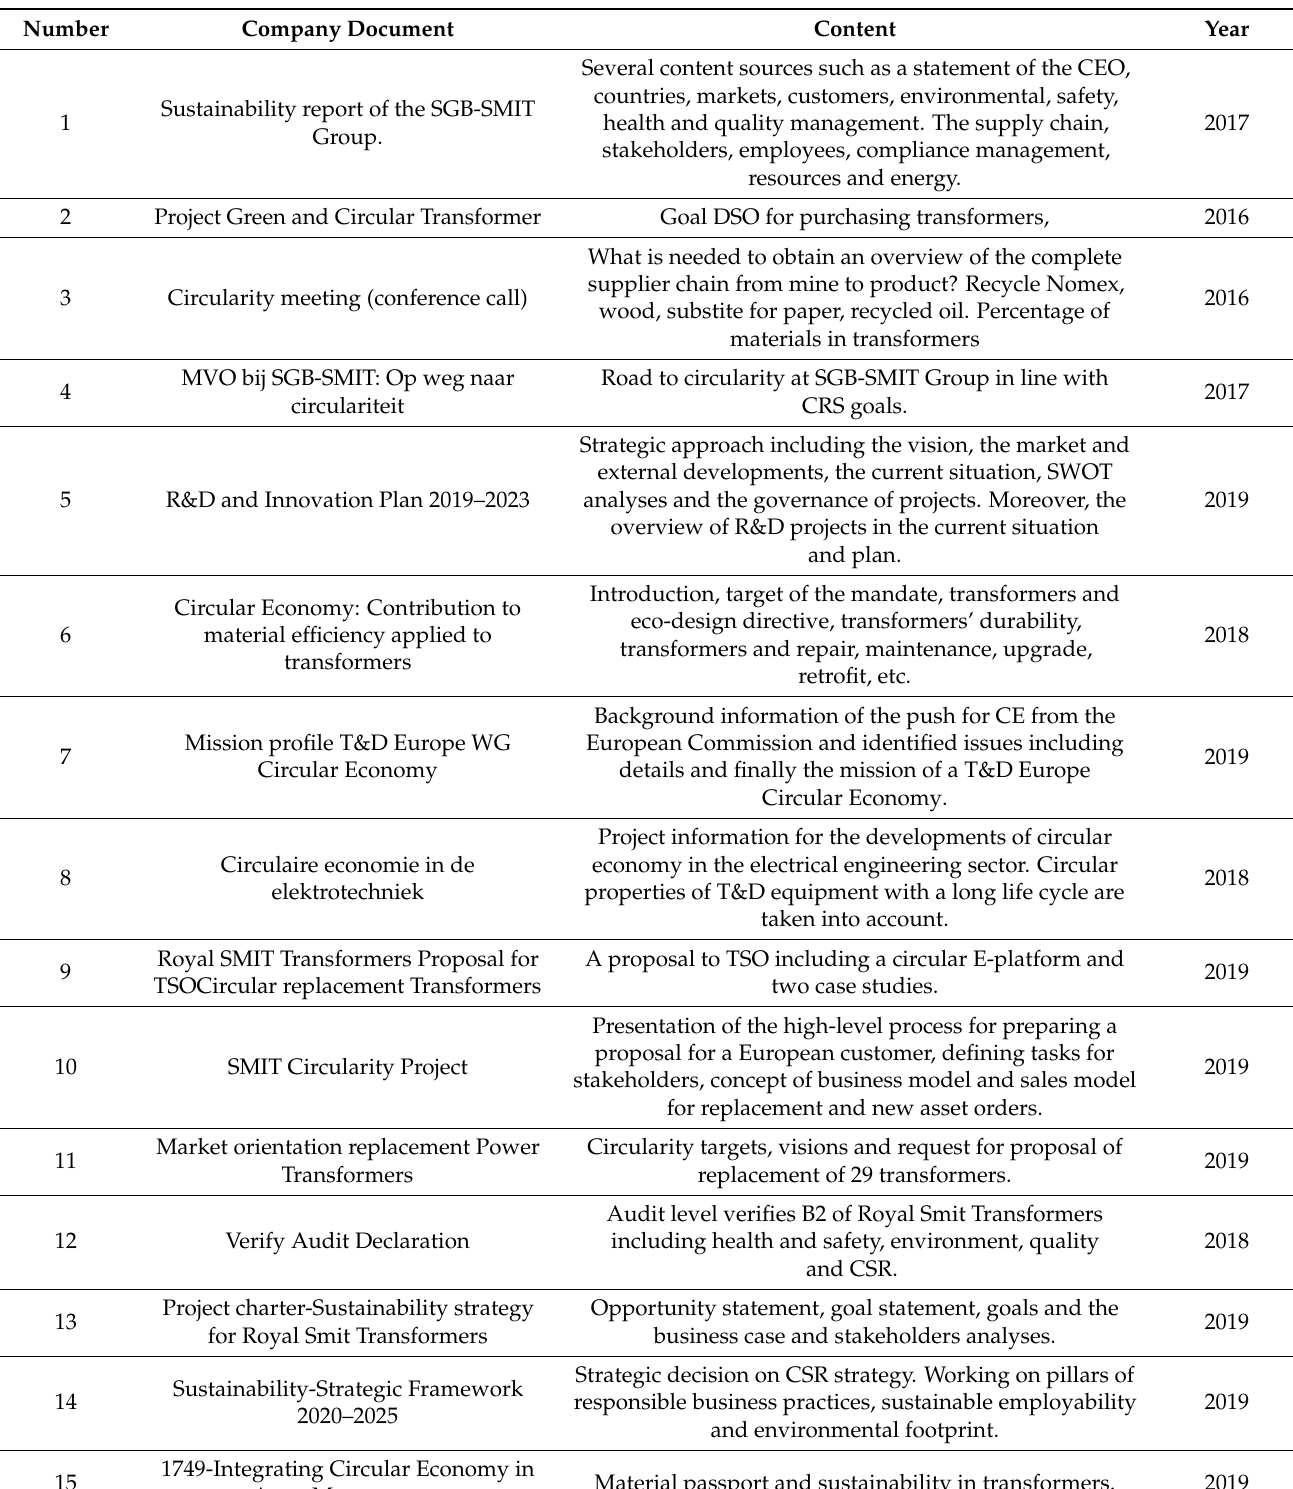
Table 1. Overview of internal